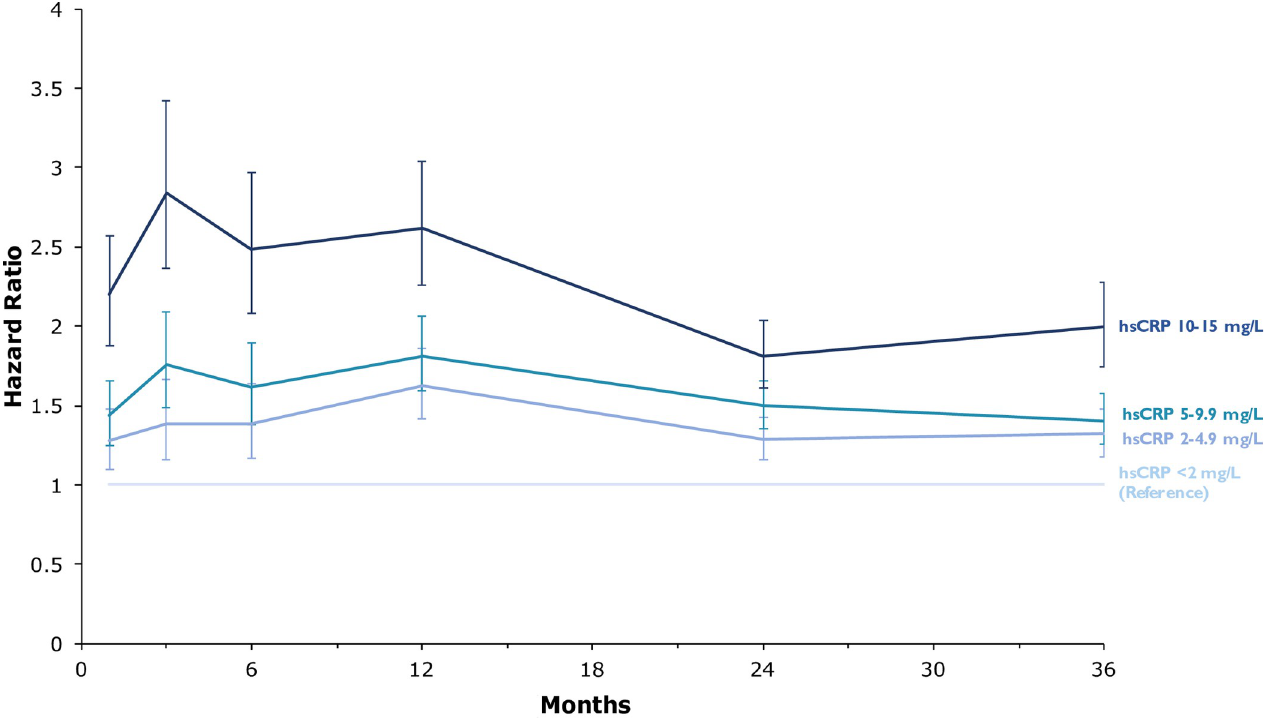
Fig 3. Multivariable Cox regression analysis with time-varying coefficients. HRs are adjusted for age, sex, haemoglobin, WCC, platelet count, creatinine, and troponin level. The adjusted HRs were calculated during the following time periods: < 1 month, 1 to 3 months, 3 to 6 months, 6 to 12 months, 12 to 24 months, and 24 to 36 months. The HRs are displayed at the end of each respective time period. The error bars depict 95% CIs. HR, hazard ratio; hsCRP, high- sensitivity C-reactive protein; WCC, white cell count.